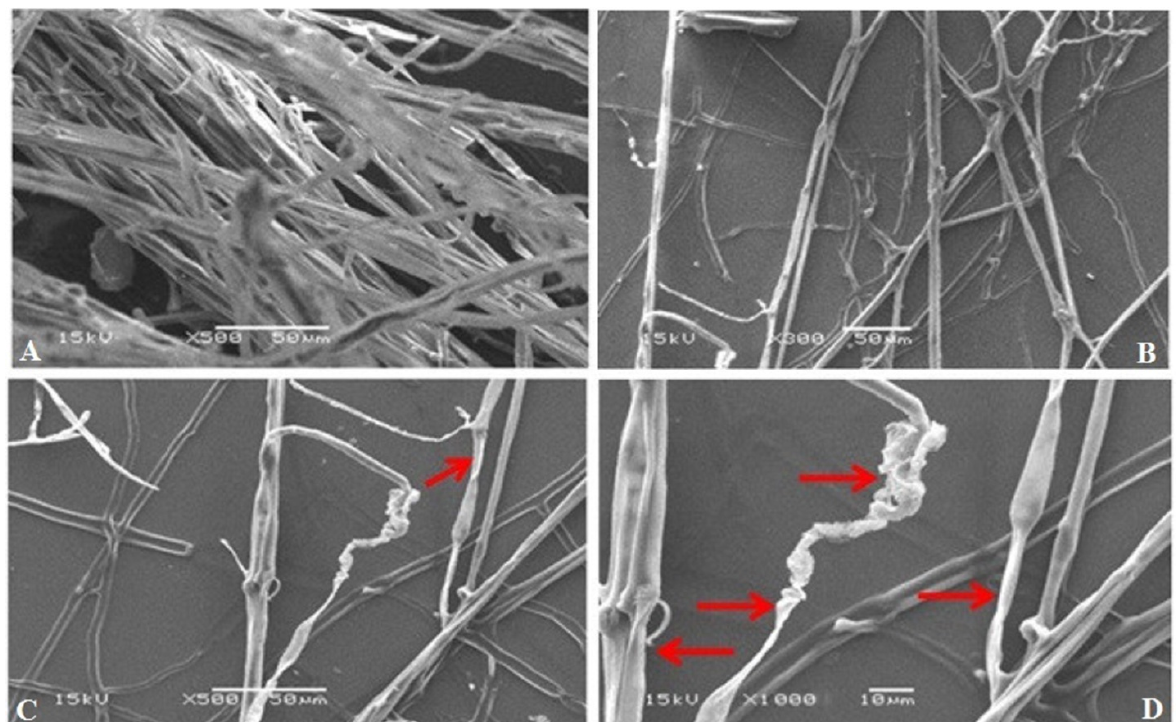
Figure 3. Scanning electron micrographs (SEM) of the antagonistic effect of Streptomyces cellulosae Actino 48 against S. rolfsii . Micrograph ( A ) is the corresponding fungus control without the antagonistic actinobacterium, and micrographs ( B ), ( C ), and ( D ) are the fungus in the presence of the antagonistic actinobacterium with different magnifications. Arrows indicate abnormality and malformation of the fungal hypha of S . rolfsii .